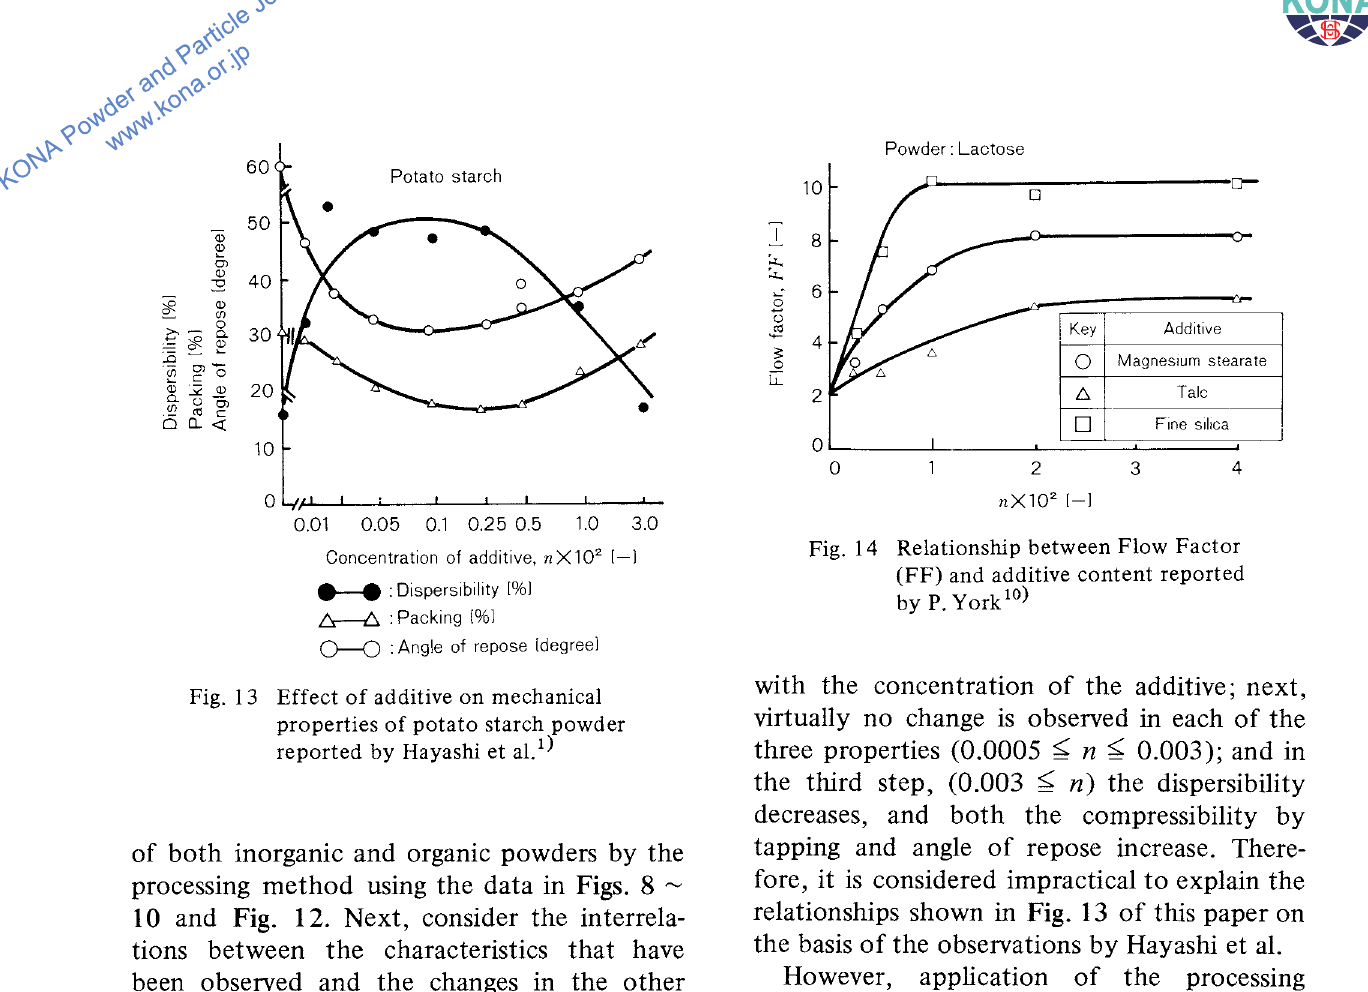
Fig. 14 Relationship between Flow Factor (FF) and additive content reported by P. York 10